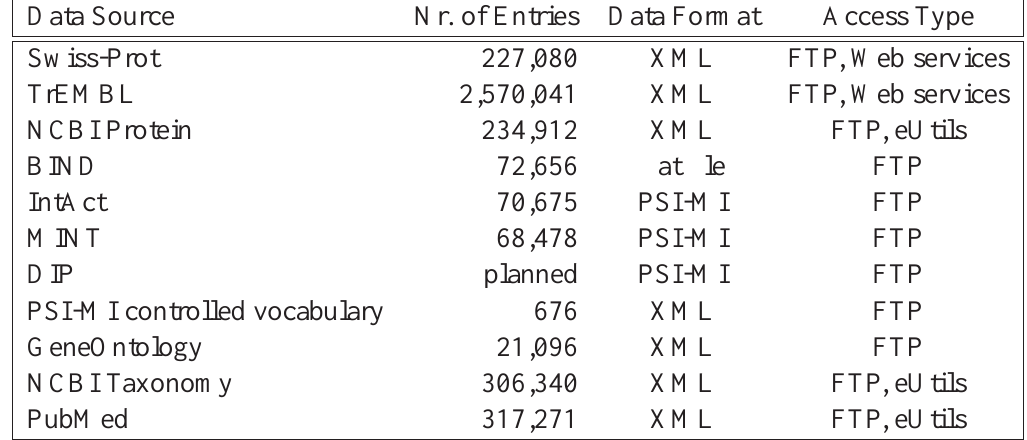
Table 1: Overview of the data sources and the combinations of format and access methods used by the Data Import Layer of the ISP system (Database statistics as of July